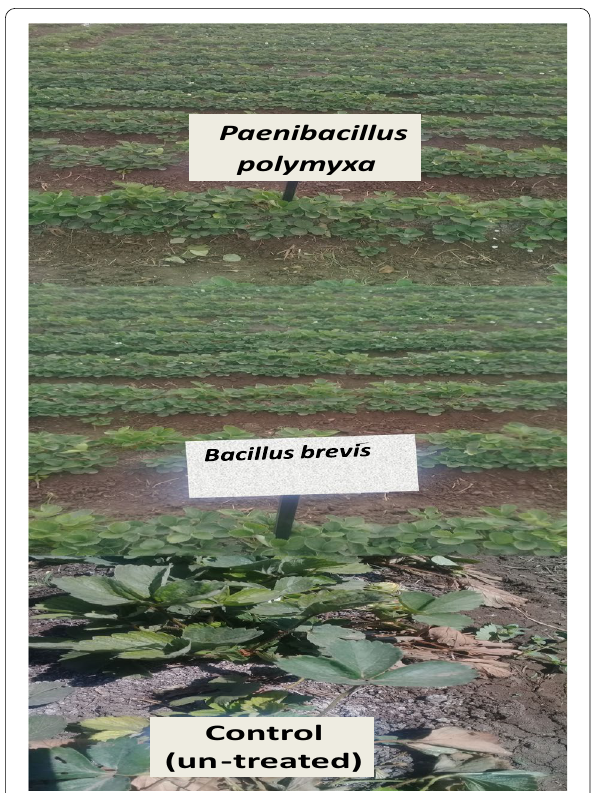
0.05) different according to DNMRT ≤